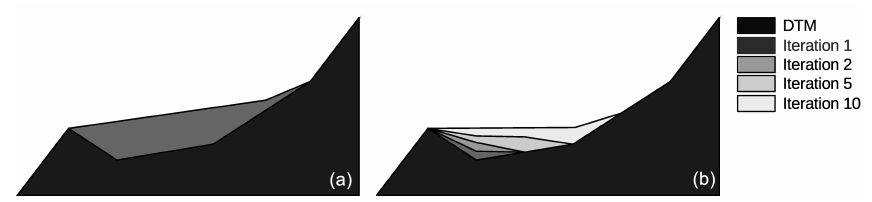
Figure 6. Longitudinal profile illustrating the sink-filling approach: (a) single model iteration, (b) 10 model